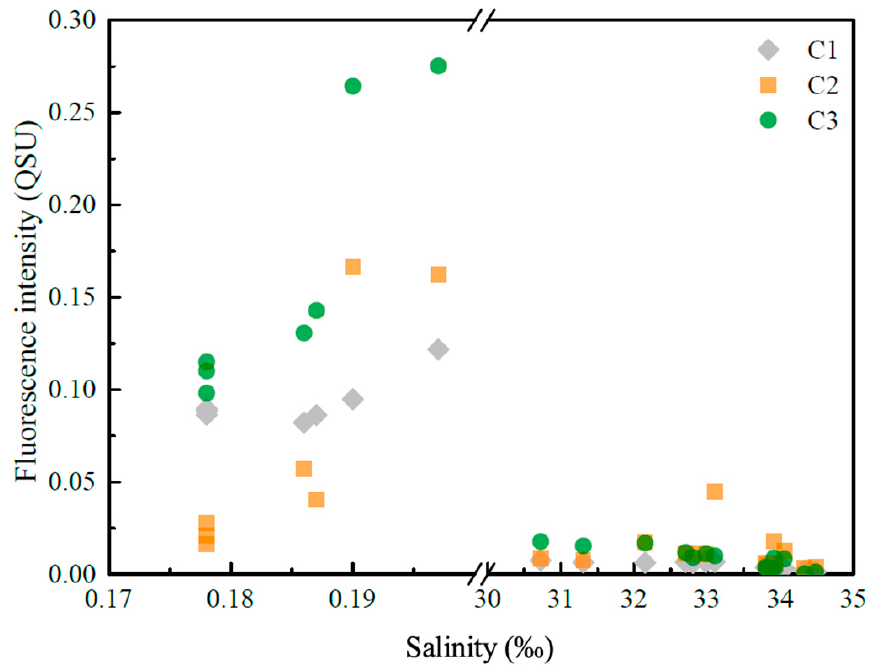
Figure 9. Variations in the fluorescence intensities of C1, C2, and C3 at the different stations. In general, the fluorescence intensities of all of the CDOM components decreased from the inner estuary to the offshore area.